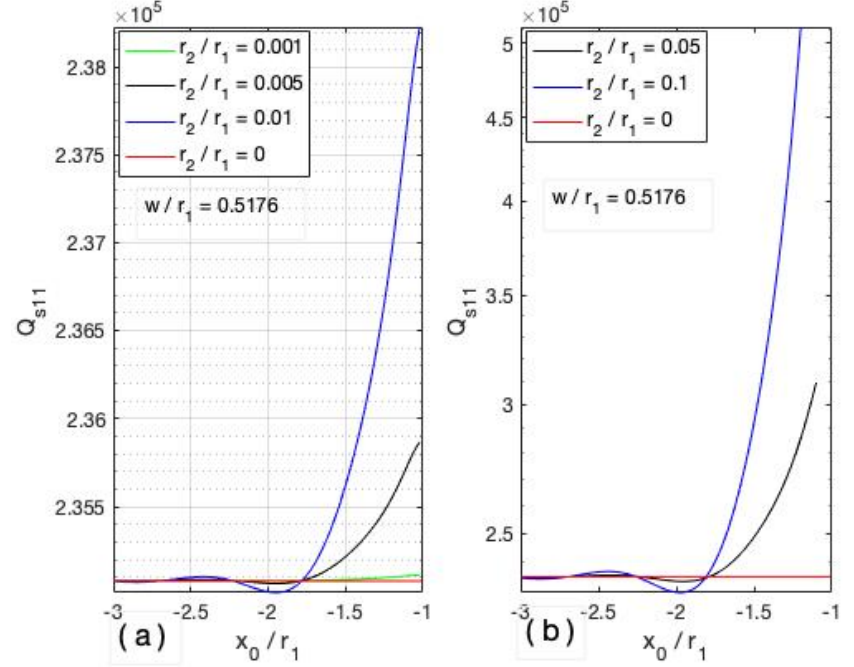
Figure 5. 𝑄 factor of anti-symmetric mode 𝑇𝑀 (cid:3046)(cid:2869)(cid:2869) versus relative distance 𝑥 (cid:2868) 𝑟 (cid:2869) ⁄ for slotted cavity Figure 5. Q factor of anti-symmetric mode TM s 11 versus relative distance x 0 / r 1 for slotted cavity ( w / r 1 ≈ 0.5176 ) with outside: ( a ) wires ( r 2 / r 1 = 0.001, 0.005, 0.01); ( b ) thin circular cylinders ( r 2 / r 1 = 0.05 , 0.1). Table 3. Influence of the PEC rod on complex eigenvalues of the open circular